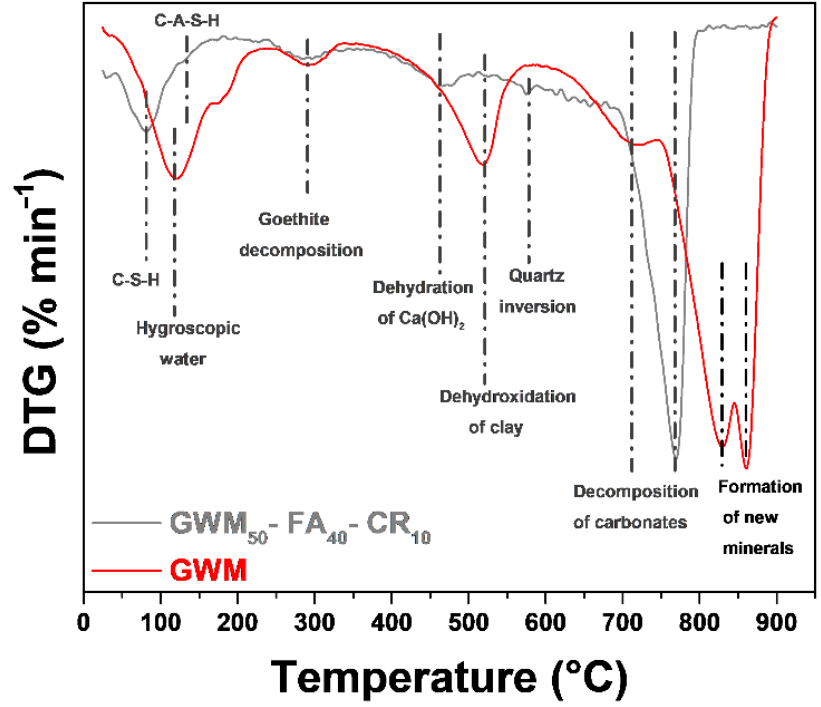
Figure 6. DTG curves of the GWM sample and GWM-FA-CR sample after 28 days of curing time. For the GWM sample, the first endothermic peak, which begins at 110 ◦ C, corresponds with the removal of hygroscopic water between the clay particles [57].